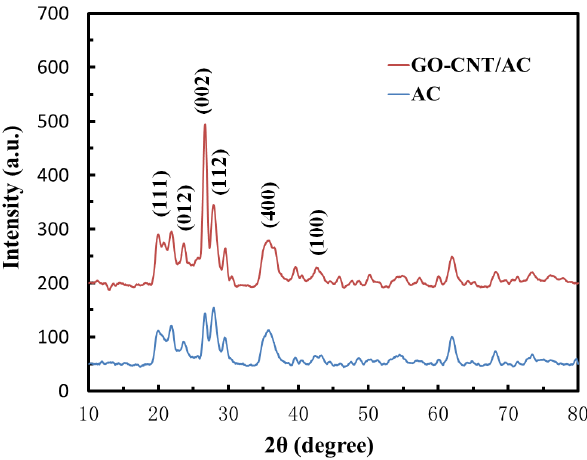
Figure 2. XRD spectra of AC and GO ‐ CNT/AC composites. Table 1. Average crystallite size and graphitization degree of AC and GO ‐ CNT/AC composites.